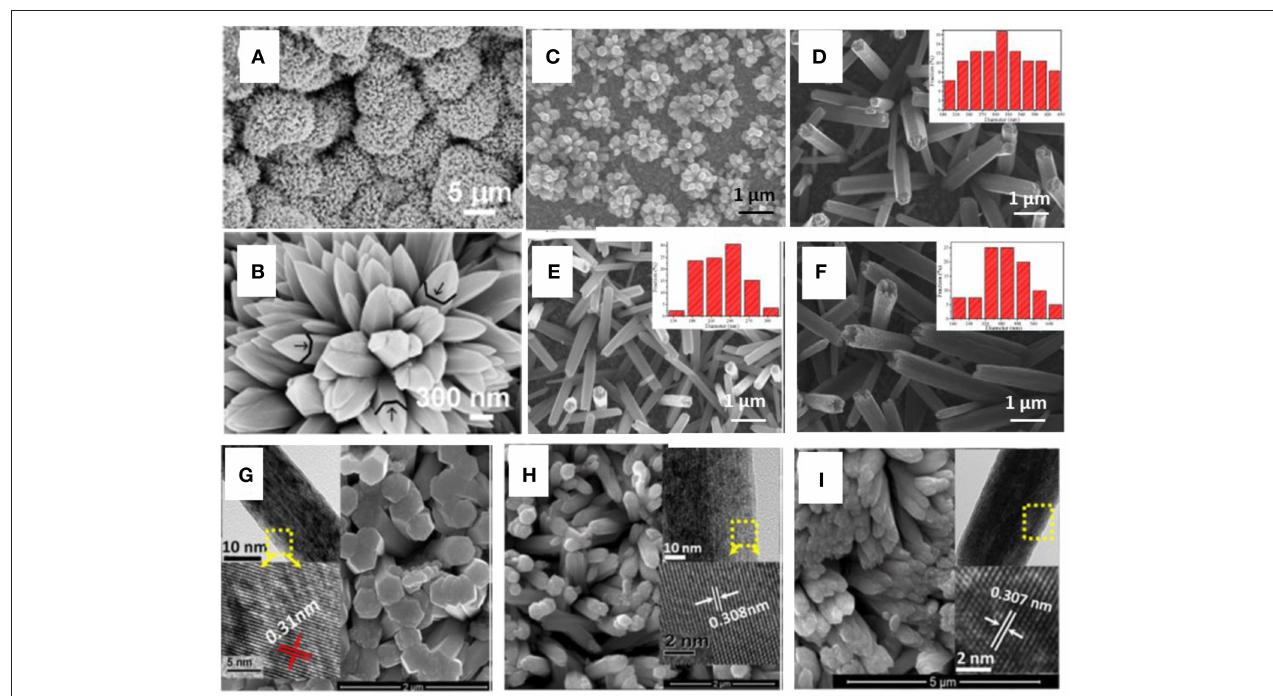
FIGURE 3 | (A) Top view SEM image of nanospikes and (B) magnified images of nanospike arrays. Reprinted with permission from Pradhan et al. (2009). copyright 2015 IOP Publishing. SEM images of (C) ZnO by 1.5h electrodeposition without initial pulse and ZnO nanoarrays with 0.1s initial pulse for (D) 0.5h, (E) 1.5h, and (F) 3h. The insets show the diameter distribution of ZnO rods. Reprinted with permission from Li et al. (2013). copyright 2013 Elsevier B.V. SEM images of as-synthesized (G) pure